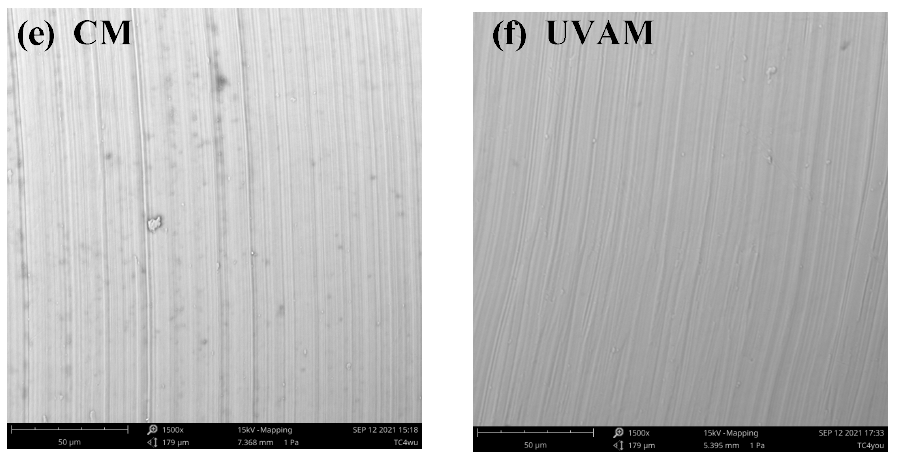
× ) of the machined surface under CM and Figure 5. SEM topography (1500 ×) of the machined surface under CM and UVAM. Figure 5. SEM topography (1500